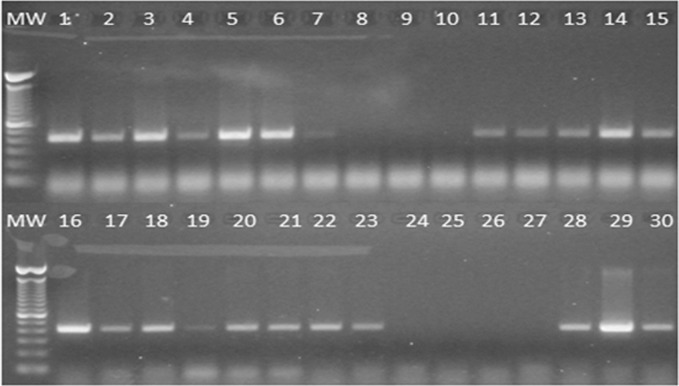
Evaluation of differently coated MyOne™ Tosylactivated Dynabeads® for magnetic separation of MAP 806PSS from a PBS suspension containing approximately 104 CFU/ml.Beads were coated separately with different MAP binders (see Table 1) and then evaluated for MS individually (10 μl of beads per ml of sample) and as 50:50 combinations (5 μl of each bead type per ml of sample). Ability to capture MAP was evaluated by IS900 PCR; the expected PCR product size was 394 bp and intensity of signal was used to assess degree of MAP capture. Key: Lanes 1 and 16, MAP 806PSS suspension before MS; Lane 2–10, coated beads 1–9 tested individually; Lane 11, beads 1 and 2; Lane 12, beads 1 and 3; Lane 13, beads 2 and 3; Lane 14, beads 1 and 4;. Lane 15, biotinylated aMp3 and aMptD peptide-coated beads (control) currently employed for MAP capture at QUB; Lane 17, beads 2 and 4; Lane 18, beads 3 and 4; Lane 19, beads 1 and 5; Lane 20, beads 2 and 5; Lane 21, beads 3 and 5; Lane 22, beads 4 and 5; Lane 23, beads 1 and 7; Lane 24, beads 2 and 7; Lane 25, beads 3 and 7; Lane 26, beads 1 and 6; Lane 27, beads 2 and 6; Lane 28, beads 3 and 6; Lane 29, beads 4 and 7. Lane 30, biotinylated aMp3 and aMptD peptide-coated beads (control). Lanes MW indicate a 100 bp DNA ladder (TrackIt™, Life Technologies).